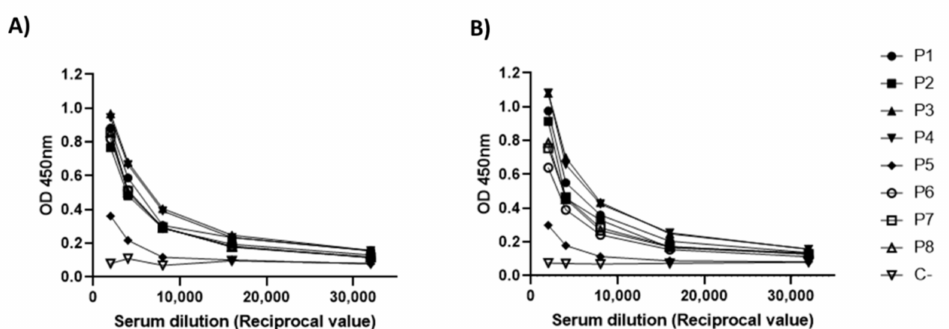
Figure 7. Immunoreaction of eight sera from patients naturally infected and recovered of COVID-19 (P1-P8) with the recombinant RBD-H6-HEK and RBD-CD. Serum was diluted from 1:2000 to 1:32,000. ( A ) ELISA using RBD-H6-HEK as coating antigen. ( B ) ELISA using RBD-CD as coating antigen. C-: Serum from a healthy